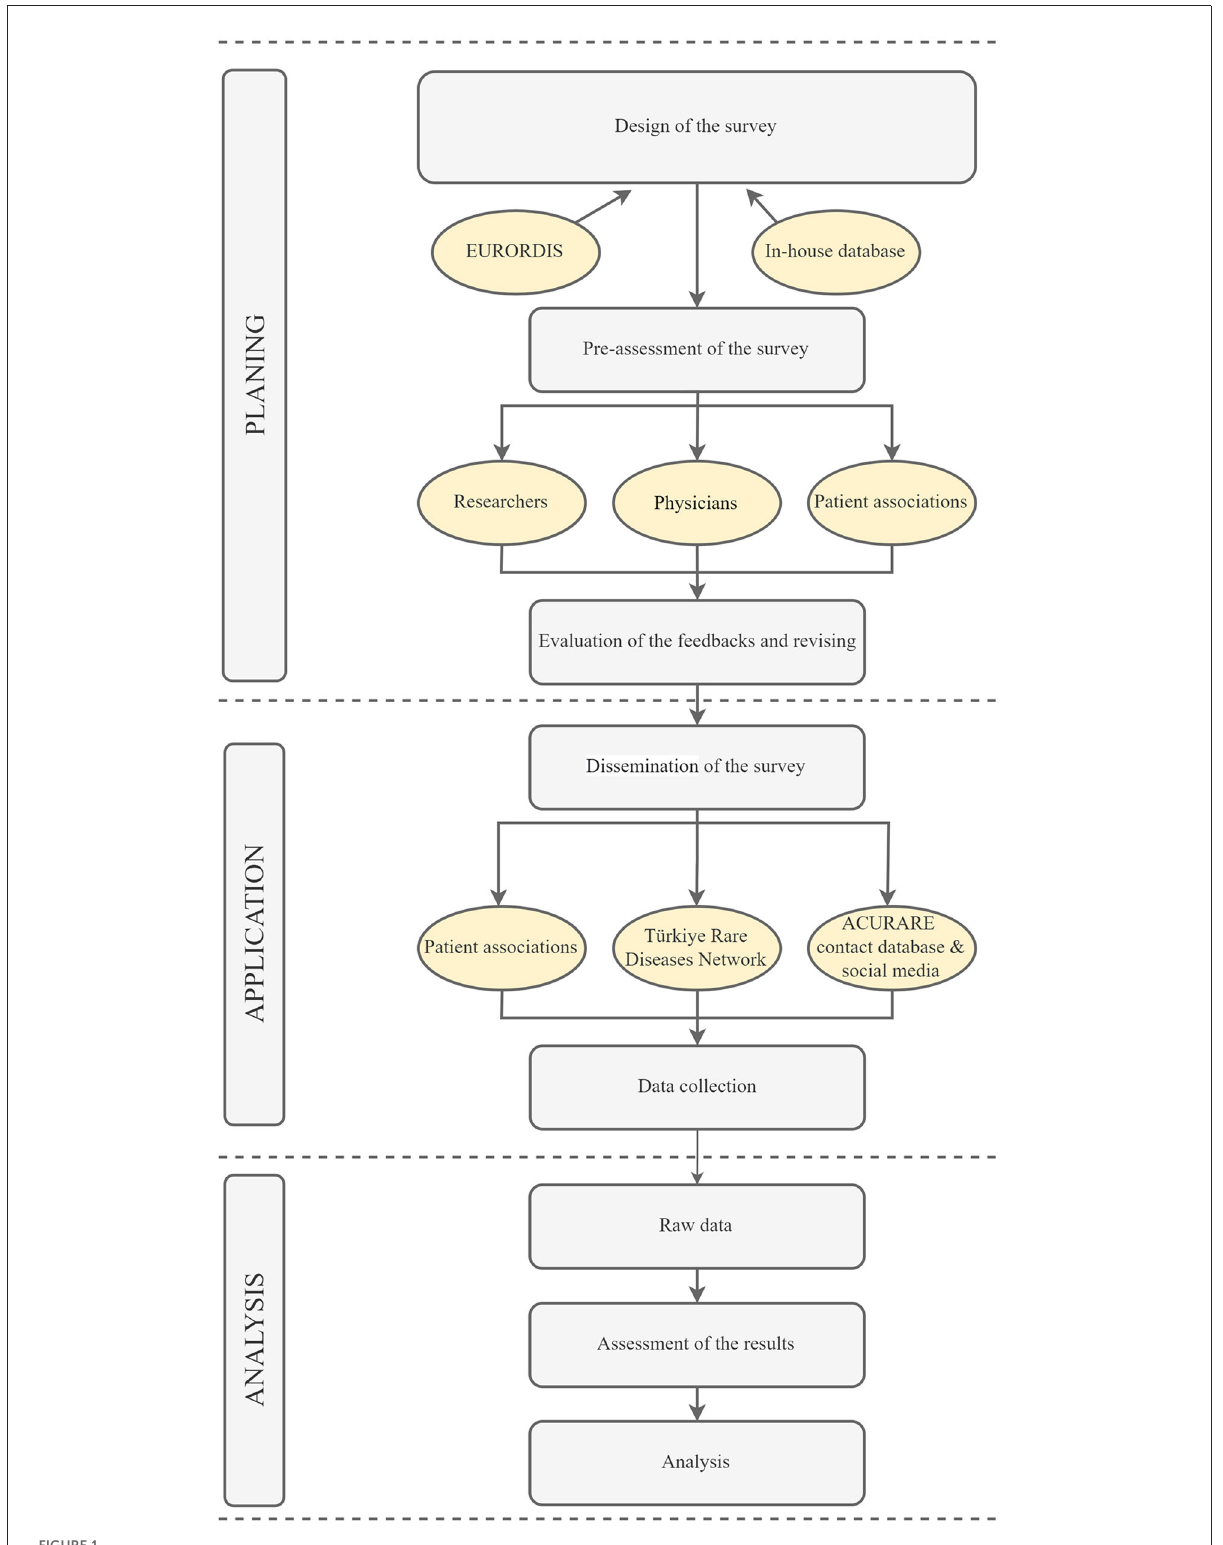
FIGURE1 The experimental flow of the survey. The survey was constructed in three main steps: planning application and analysis. The questions were gathered from previously conducted surveys that are relevant for patients in Türkiye. Additional questions were created for country specific conditions. The dissemination of the survey was done through patient associations, Türkiye Rare Disease Network and ACURARE in-house contact databases, in addition to social media accounts of ACURARE, (Instagram: acuraretr, Twitter: acurare1, LinkedIn: ACURARE). The data were retrieved directly from the SurveyMonkey platform, exported to SPSS V21, and analyzed by the independent consultant service provider. The figure was created by Draw.io